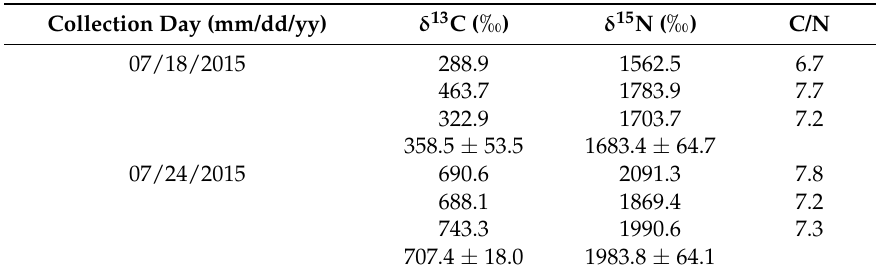
Table 2. δ 13 C and δ 15 N signatures of labeled mucus released by Acropora corals. C/N ratios were determined as %C/%N of the samples. Bold values indicate mean (± SE) of triplicate measurements.